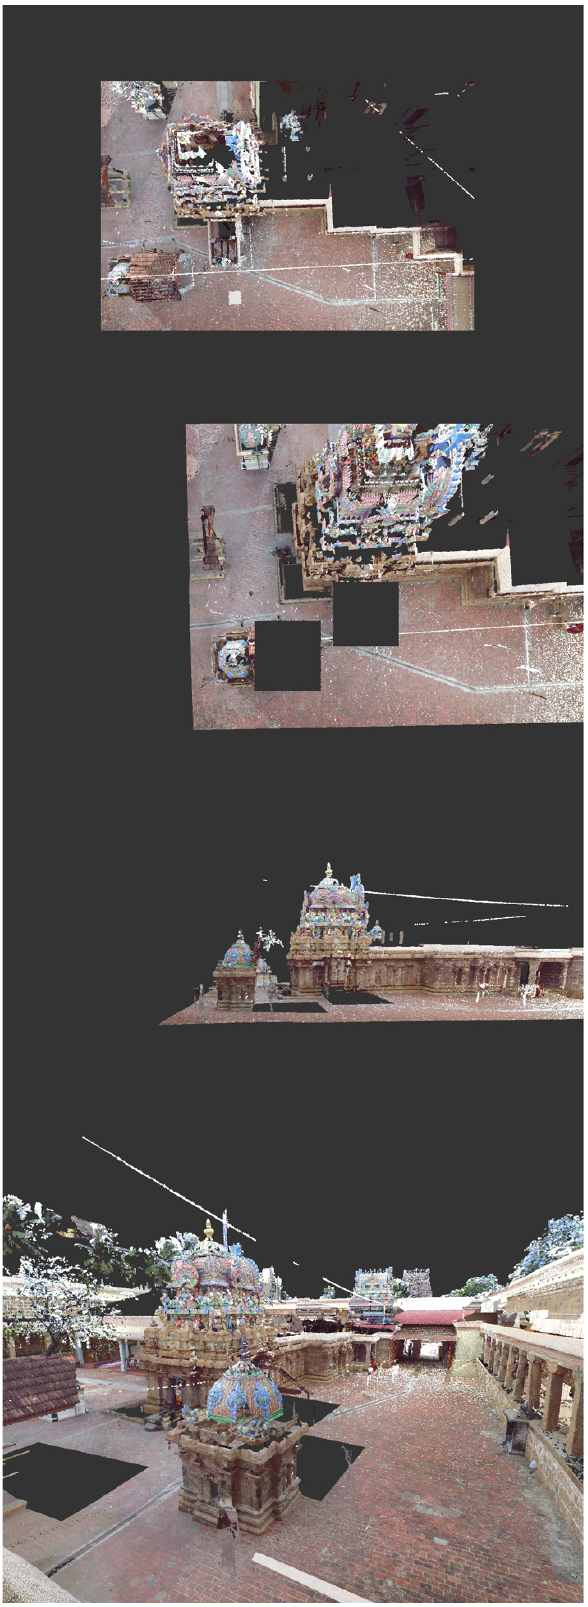
Figure 14. Sequence showing digital